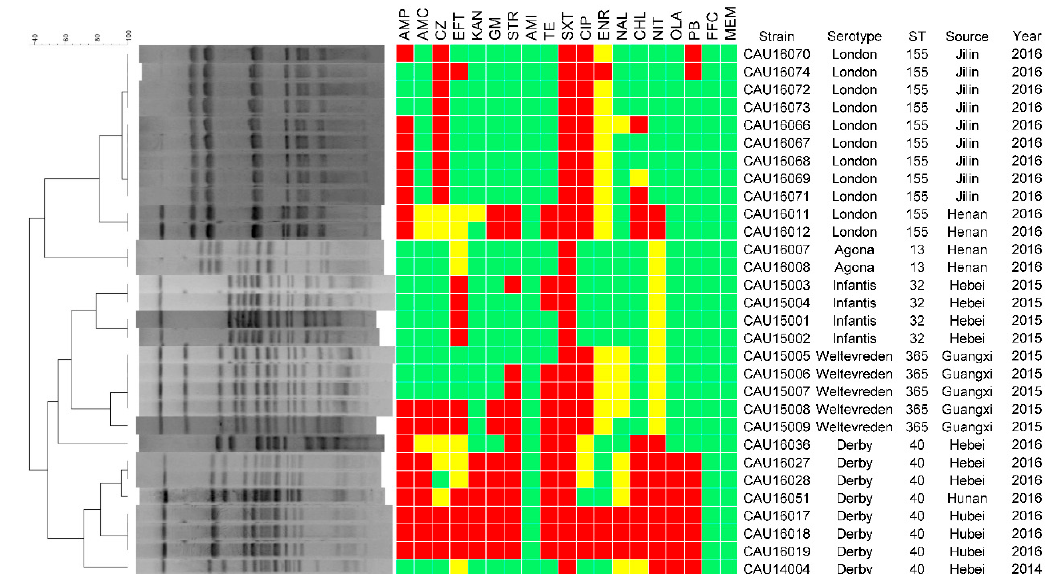
Figure 2. PFGE patterns and antimicrobial resistance profiles of all the Salmonella isolates except S. Typhimurium and S. 4,[5],12:i:-. Dendrograms of Xba I-PFGE are presented on the left, and the results of the antimicrobial susceptibility tests are shown to be aligned with the dendrograms. Red indicates resistance to the corresponding antimicrobials, yellow indicates intermediate susceptibility, and green indicates susceptibility.